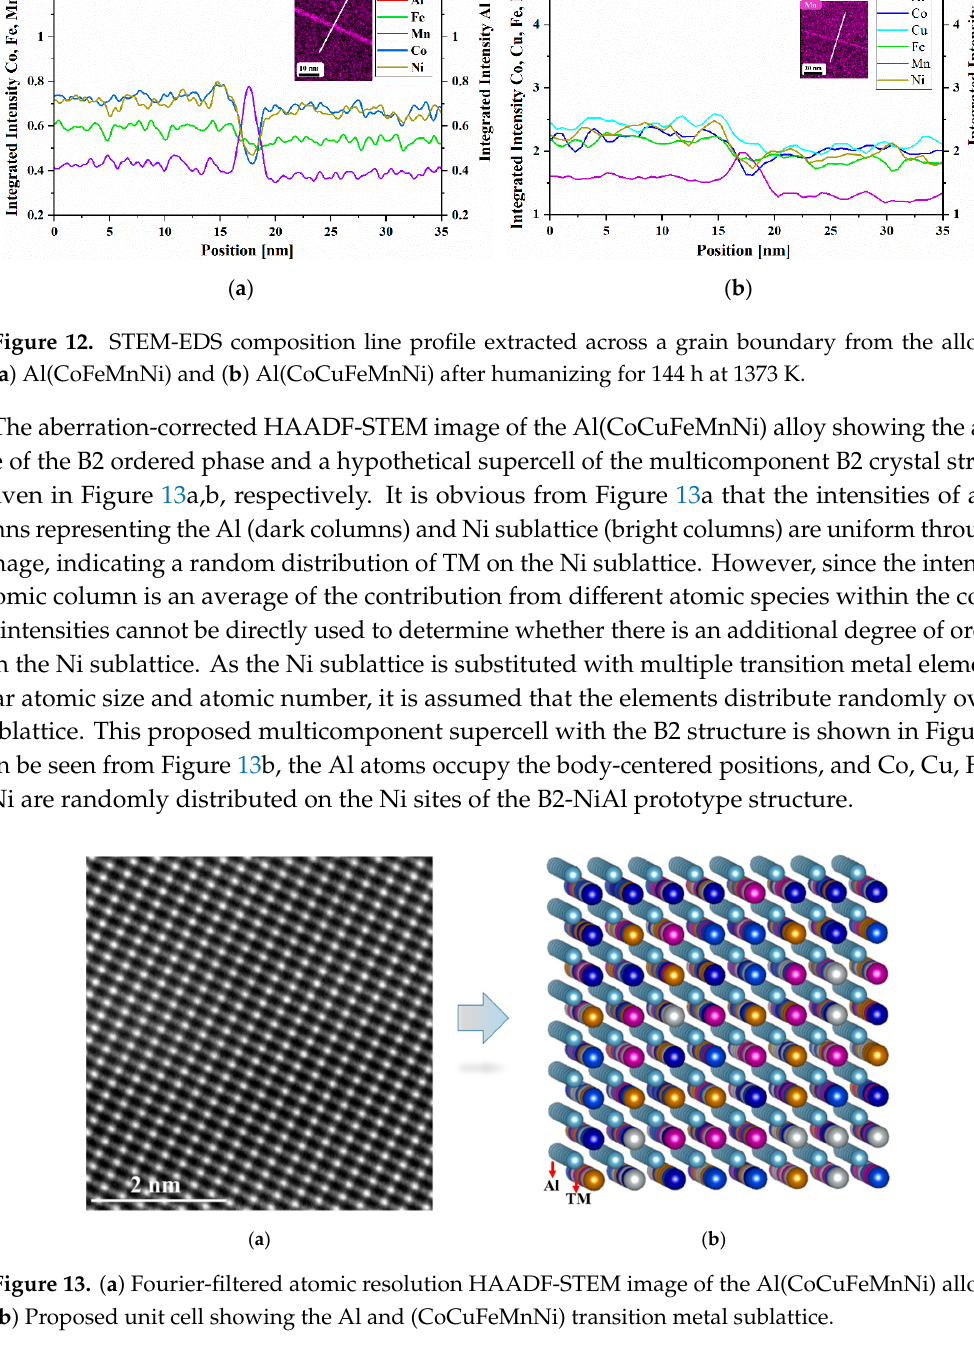
Figure 11. Aberration-corrected HAADF-STEM analysis of Al(CoCuFeMnNi) B2 aluminide shows ( a ) HAADF-STEM image and corresponding STEM-EDS elemental maps of constituent elements; ( b ) the atomically resolved HAADF-STEM image of the B2 ordered lattice.